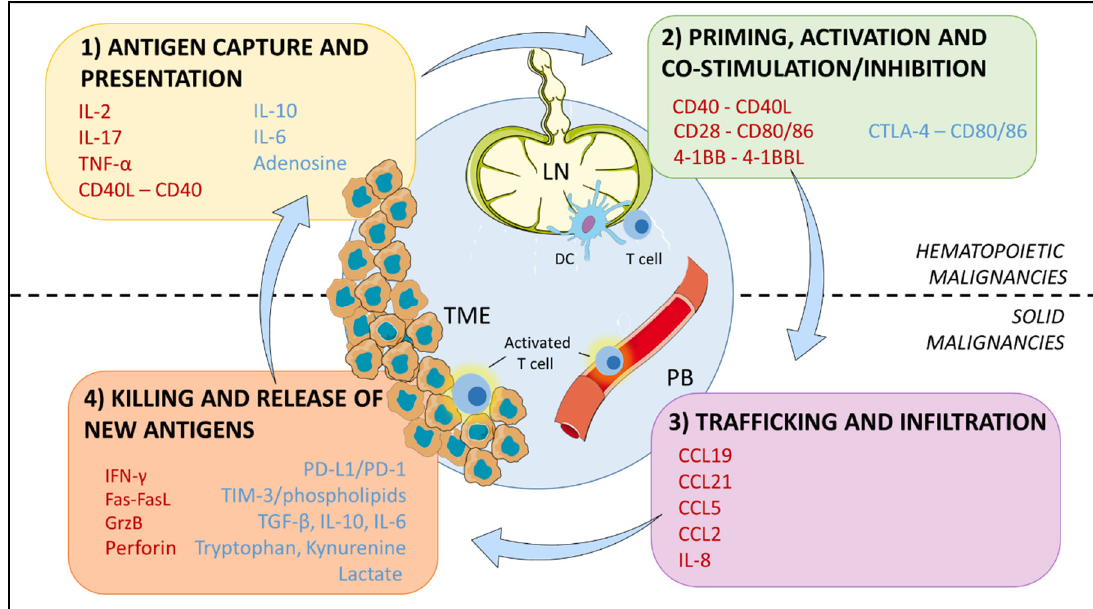
Figure 1. Cancer-immunity cycle. The immune response against cancer starts in the tumor microenvironment (TME) where antigens released by cancer cells are captured by dendritic cells (DCs), followed by antigen presentation to T cells in the lymph node (LN) for their priming. Activated T cells traffic through peripheral blood (PB) and infiltrate the tumor bed to kill cancer cells. The cycle is propagating with new antigen release. Immunostimulatory and inhibitory factors promoting or suppressing the cycle are indicated in red and blue, respectively. Antigen presentation and priming is the main mechanism affected in B cell malignancies, while T cell dysfunction in solid cancers is predominantly due to defective tumor infiltration and killing in the TME. Figure adapted from REF [3] to match the scope of this review.